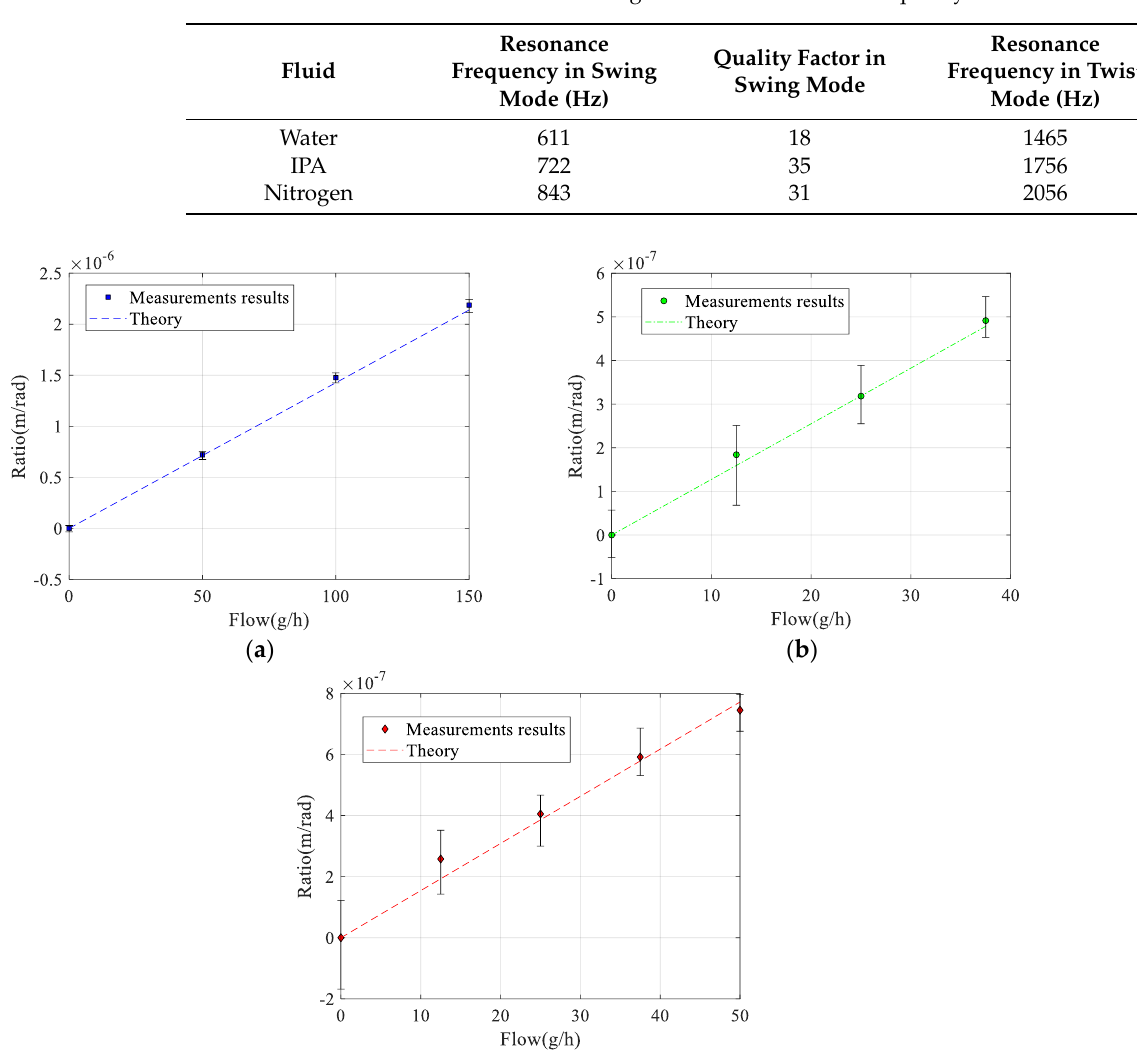
Figure 10. Measured mass flow rate as a function of applied mass flow rate for water, IPA, and nitrogen, using the theoretical response (14) to convert the measured response into the correspond- ing mass flow. The pressure drop over the tube vs. flow rate is shown in Figure 11. An estimation of the pressure drop based on the Hagen–Poiseuille equation shows that the maximum